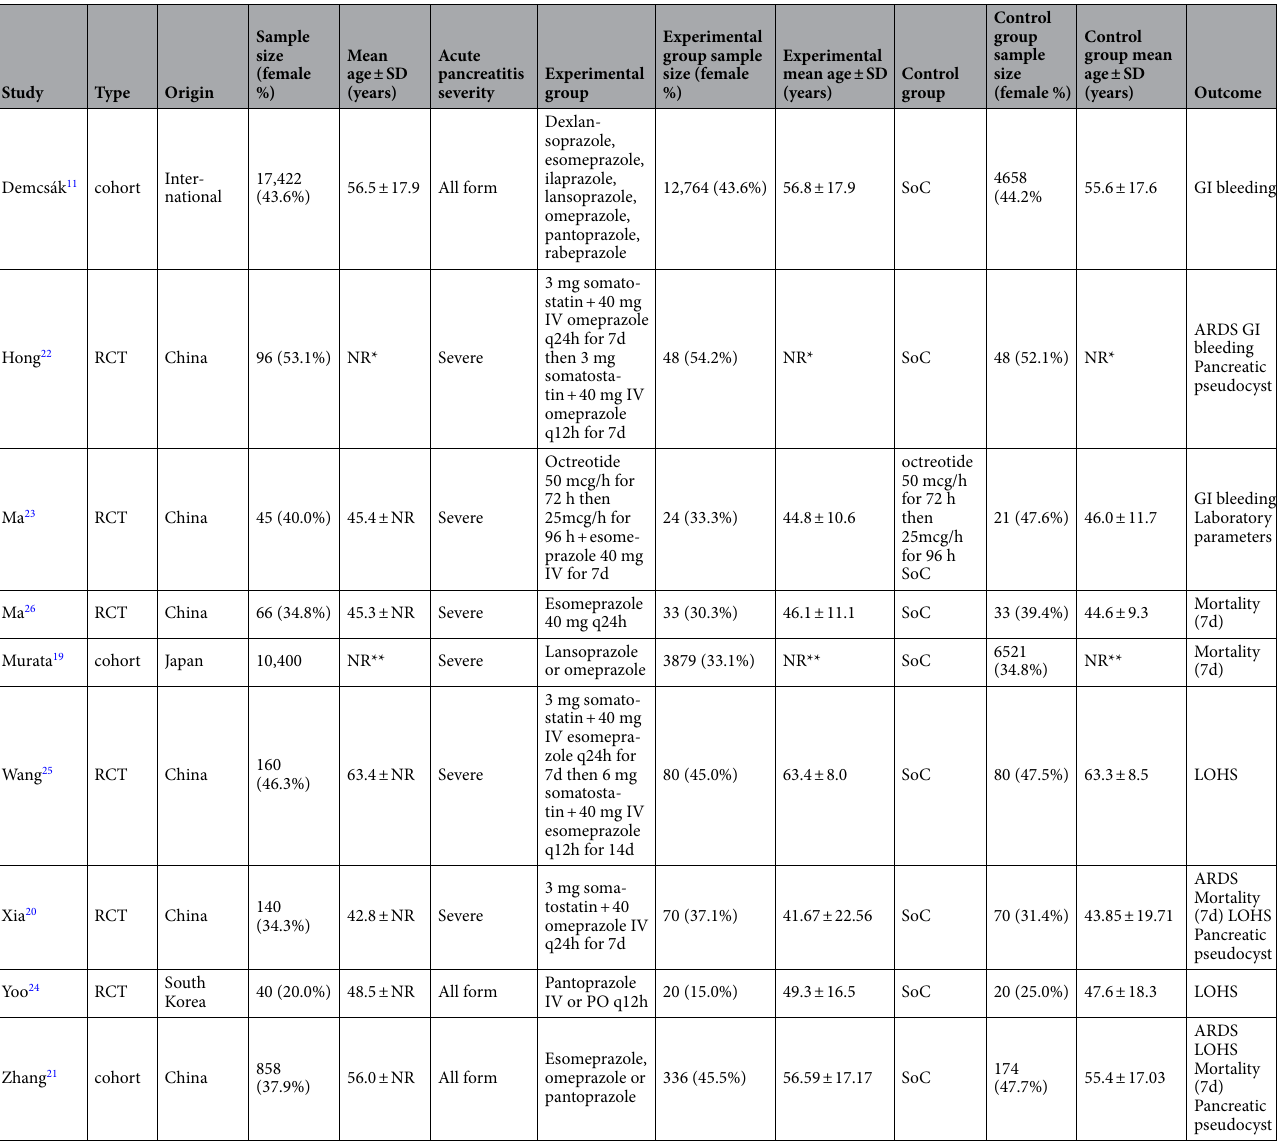
Table 1. Baseline characteristics of included articles. SD standard deviation, RCT randomized controlled trial, PPI proton pump inhibitor, SoC standard of care, NR not reported, mg milligram, mcg microgram, IV intravenous, PO per os, q every, h hour, d day, GI gastrointestinal, ARDS acute respiratory distress syndrome, AKI acute kidney injury, LOHS length of hospital stay. *Min–max age was reported. **Age groups were